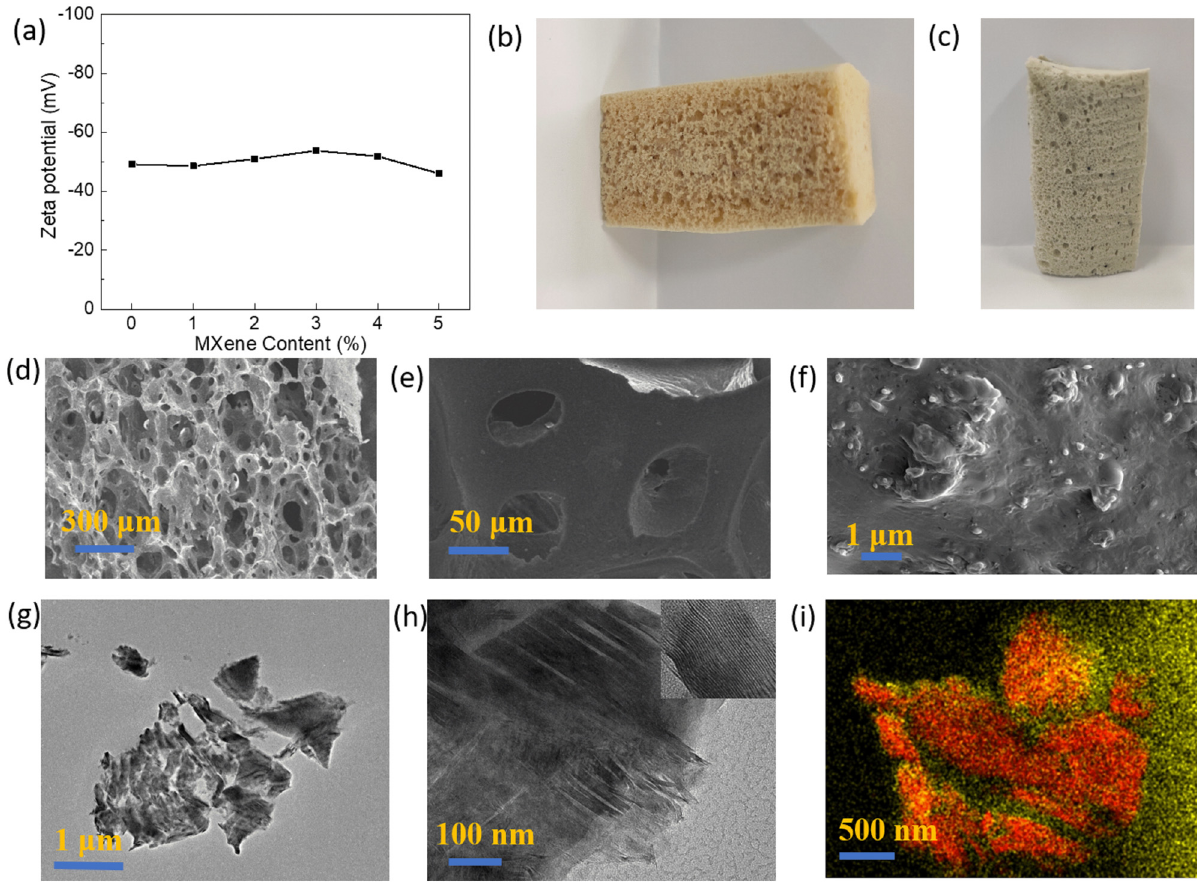
Figure 3: ( a ) Zeta potentials of di ff erent MXene copies to natural rubber latex; ( b and c ) SEM images of cure NRF and NRMF - 1; ( d – f ) SEM images of NRMF - 3; ( g and h ) TEM images of NRMF - 3; the inset of ( h ) is high - resolution TEM of MXene sheets; and ( i ) EDS elemental mapping.